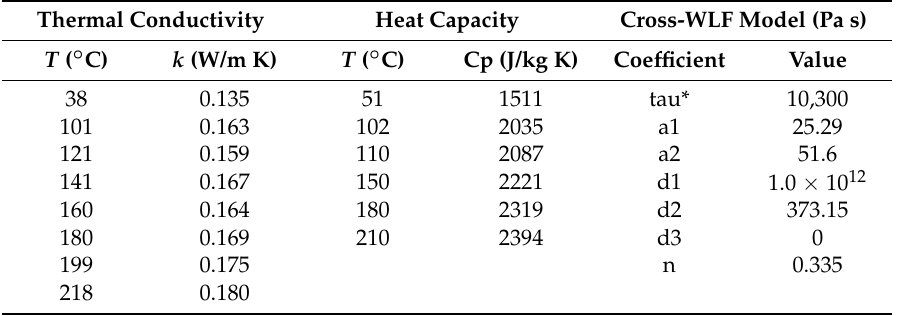
Table 2. Modeled properties of processed high-impact polystyrene (HIPS) (Styron 478).